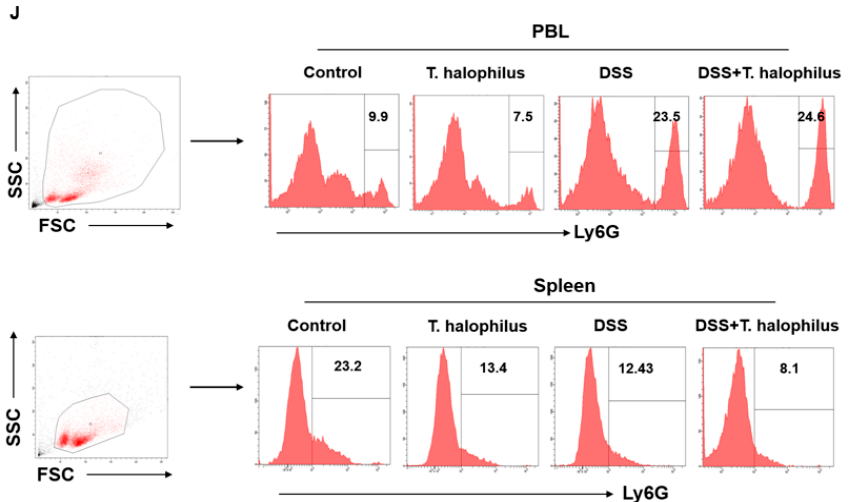
Figure 4. Effects of T. halophilus on Ly6G+ cells in DSS-induced colitis mice. Frequencies of CD11b+, Ly6G+, and CD11b+Ly6G+ cells in the surface of peripheral blood leukocytes (PBL) splenocytes, and intestinal epithelial cells (IELs) of normal control mice, normal mice treated with T. halophilus (4.8 × 10 8 CFU/mouse/day), DSS-induced colitis mice, and colitis mice treated with T. halophilus (4.8 × 10 8 CFU/mouse/day) for 10 consecutive days were evaluated by flow cytometric analysis ( A – I ). Representative histograms of Ly6G+ cell frequencies in PBL and spleen are shown in ( J ). One-way ANOVA followed by Bonferroni’s multiple comparison test was performed with GraphPad for statistical analysis. Four mice were used in each experimental group. Experiments were performed independently at least twice. Significantly different p- values are indicated by an asterisk as follows: *, p < 0.05; **, p < 0.01; ***, p < 0.001.